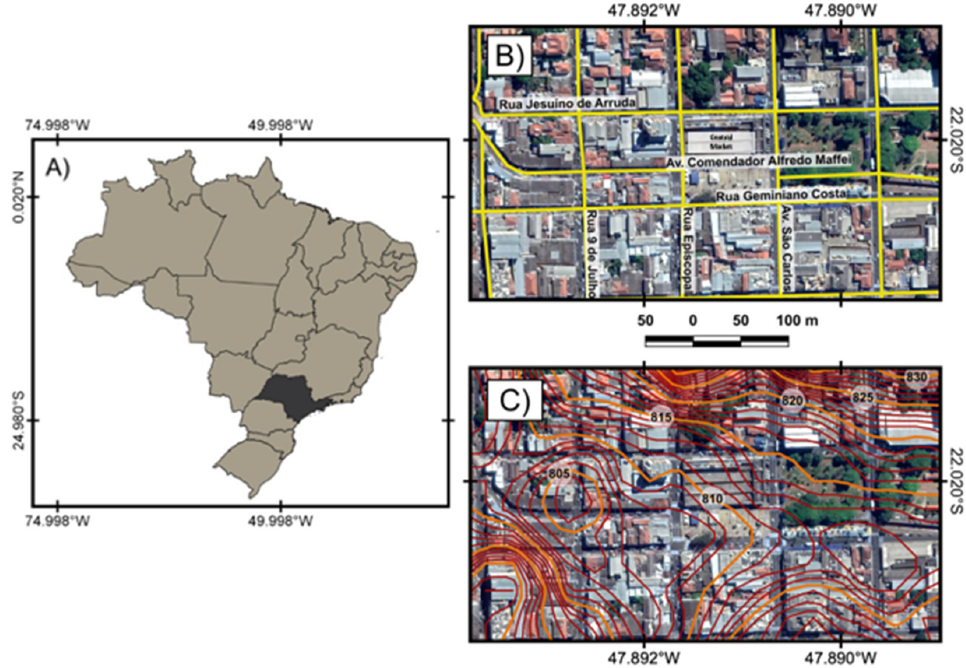
Figure 1. Map of the case study. ( A ) Location of São Carlos city. ( B , C ) Region affected by the floods. ( B ) Street names surrounding the area; ( C ) topography of the region.